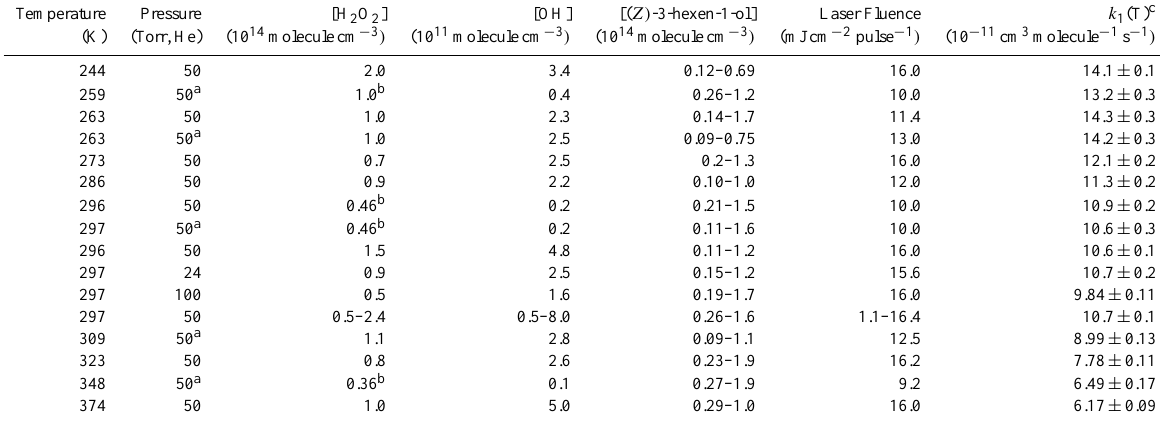
Table 2. Summary of experimental conditions and measured rate coefficients, k 1 ( T ), for the OH+( Z )-3-hexen-1-ol reaction. Temperature